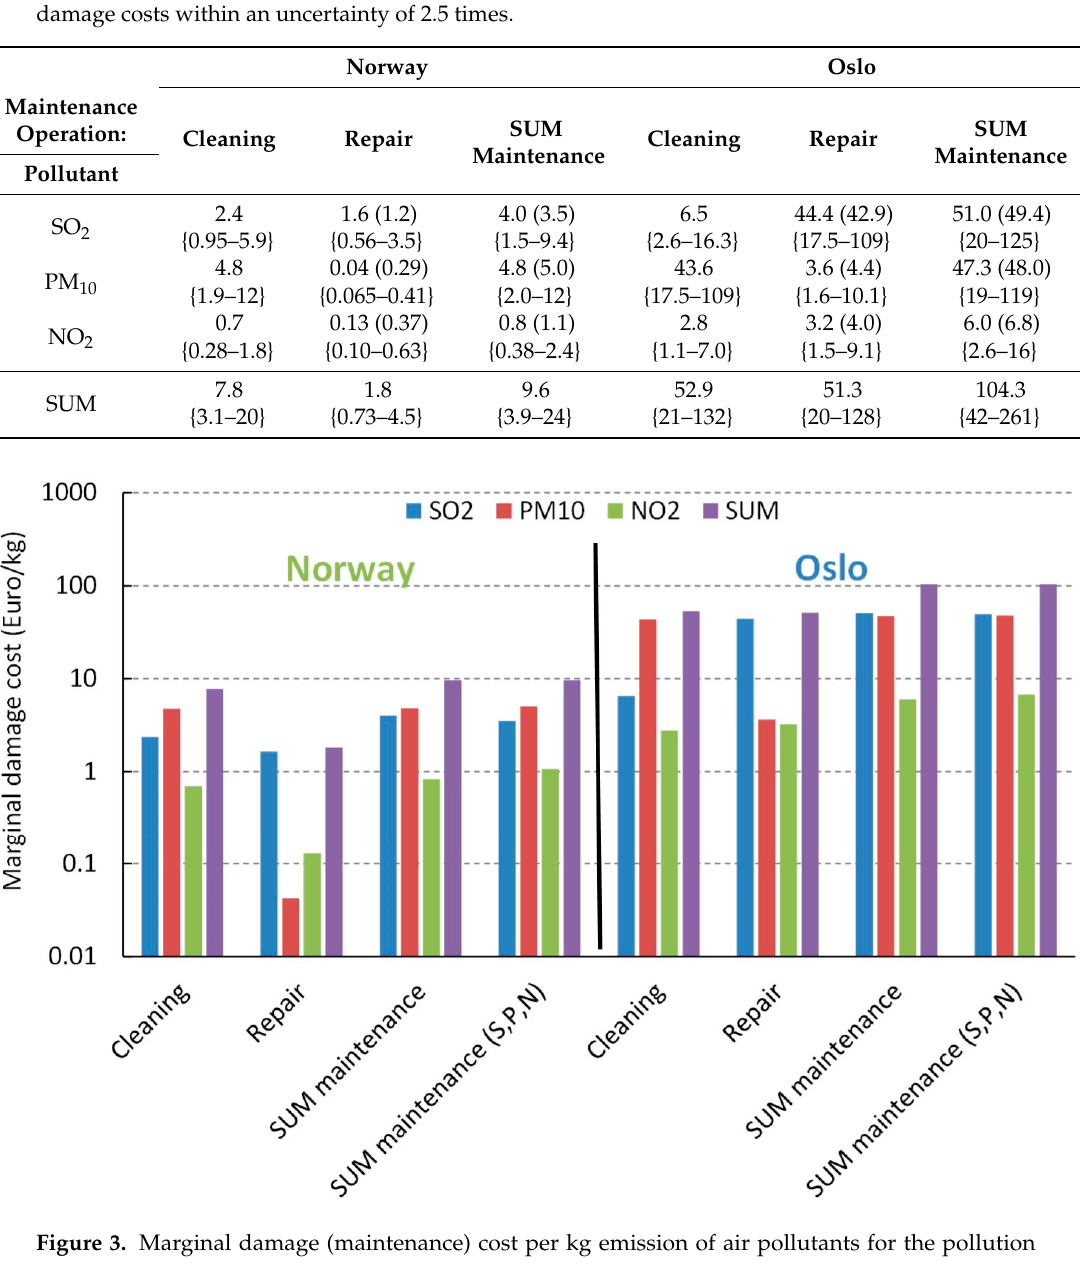
Figure 3. Marginal damage (maintenance) cost per kg emission of air pollutants for the pollution scenarios in Norway and Oslo, for cleaning, repair and maintenance (cleaning and repair) due to soiling and atmospheric chemical wear by influencing pollutants. Table 6. Marginal maintenance cost for façades due to atmospheric wear per kg emission of air pollutants (Euro/kg) in Norway and Oslo. The values in round brackets () show the results if the pollution impact on the painted materials (of steel, other metals, and wood) was attributed equally to SO 2 , PM 10 , and NO 2 , rather than to SO 2 only. The values in curly brackets {} show the ranges for the damage costs within an uncertainty of 2.5 times. Norway